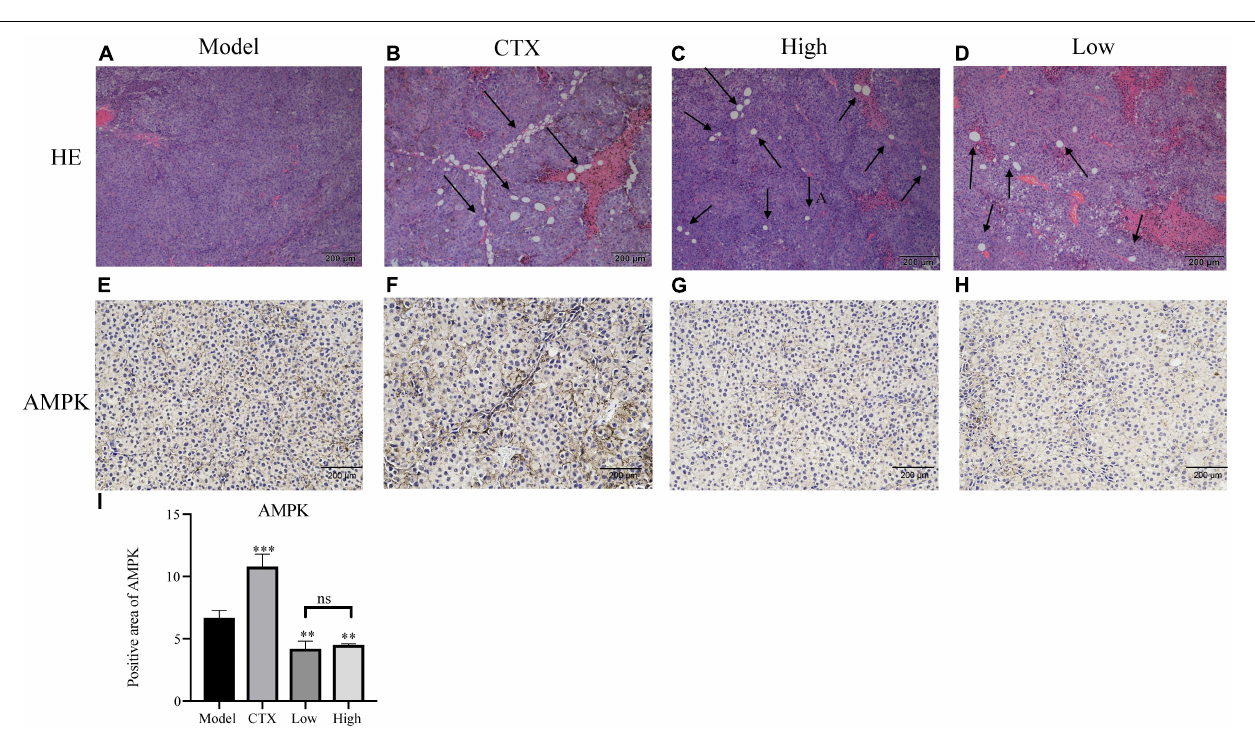
FIGURE 6 | Effects of LBMP-2 on tumors in melanoma tumor-bearing mice. (A–D) Representative H&E staining images of tumor sections separated from melanoma tumor-bearing mice. (E–H) Representative immunohistochemistry images of tumor sections separated from melanoma tumor-bearing mice. (I) Positive area of AMPK ( ∗∗ p < 0.01, ∗∗∗ p < 0.001, and ns: no significant difference).